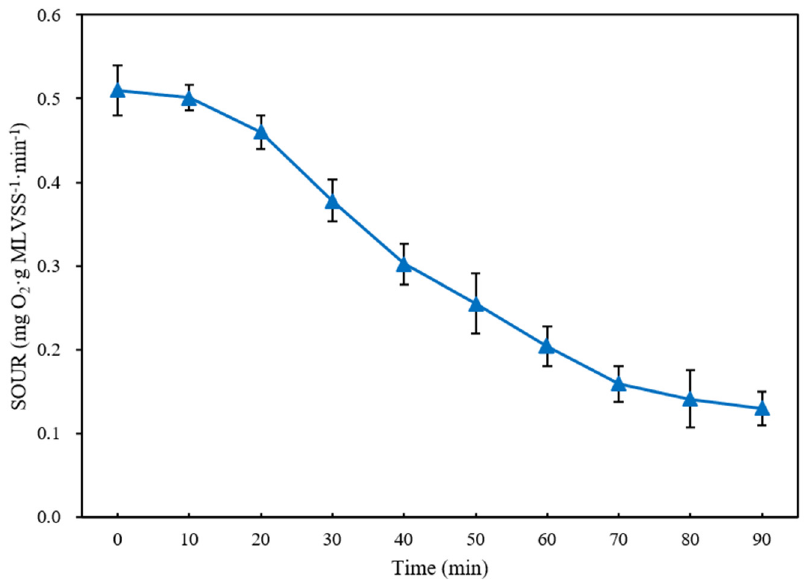
Figure 5. The variation of sludge specific oxygen uptake rate (SOUR) during electrochemical cell